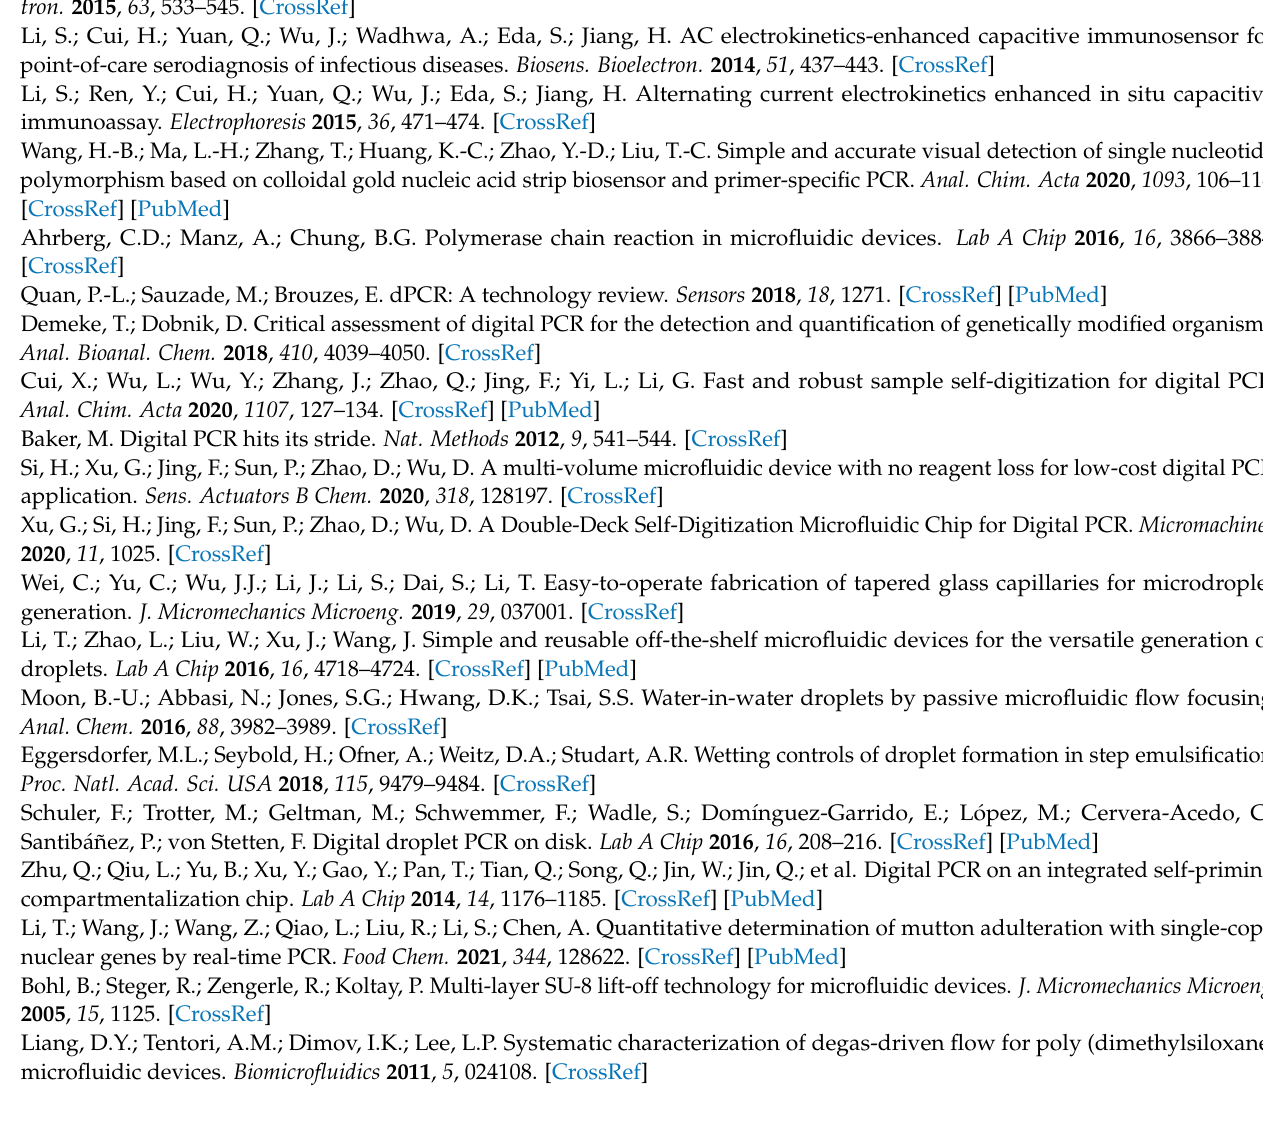
Figure S2: Experimental results of meat authentication applications with the fluorescence images before and after image process to read out the total numbers of positive